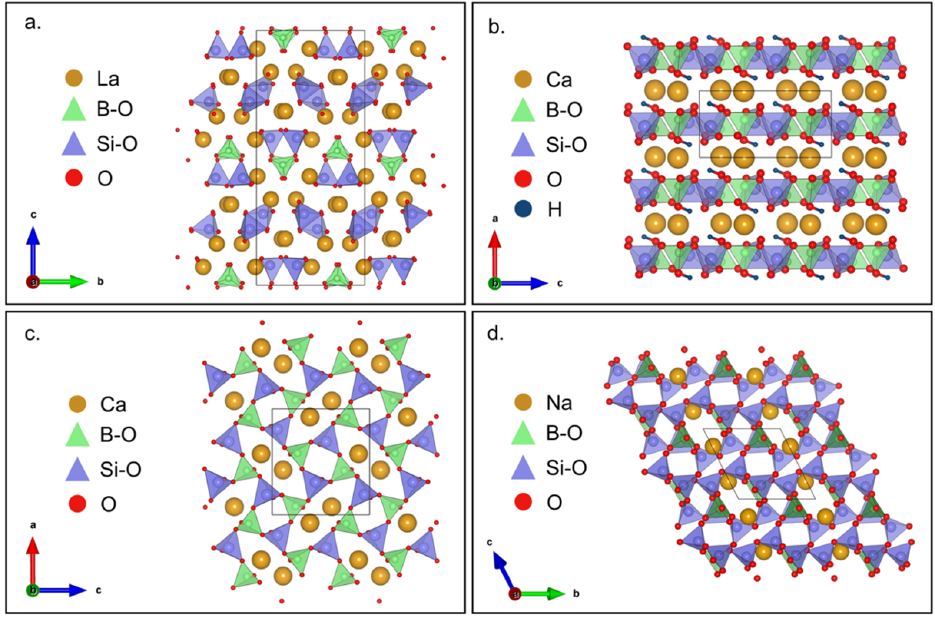
Figure 10. Polyhedral representation of borosilicate structures [41]: ( a ) La 3 BSi 2 O 10 with isolated units; ( b ) CaBSiO 5 H with layered structure; ( c ) CaB 2 Si 2 O 8 and ( d ) NaBSi 3 O 8 with 3D frameworks.